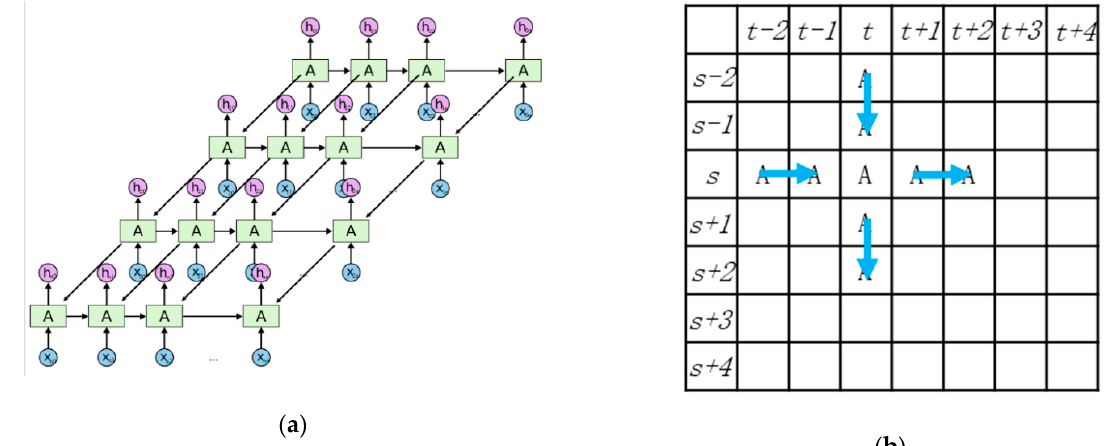
Figure 7. ( a ) The model structure of MDLSTM. ( b ) The application in the accident analysis . ” t ” and “ s ” shows the coordi- nate location of the grid cell. For example, the ( t − 1, s ) is the left grid cell of ( t, s ). ”A” in this figure shows the MDLSTM cell in a special location, for example the “A” in the t th column and s th row corresponding to the MDLSTM cell in the same location. The blue arrow means the information transfers from the neighboring grid cell.